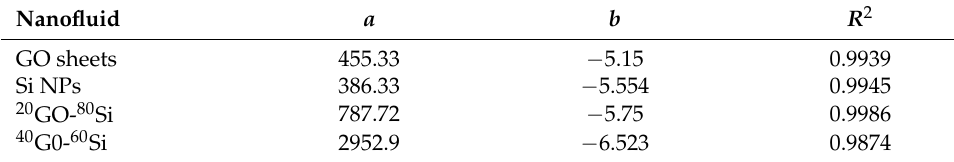
Table 1. Coefficient values a , b , and R 2 obtained by fitting Equation